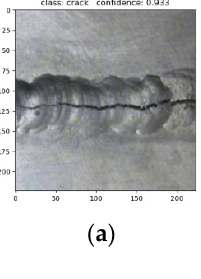
Figure 12. Prediction results of weld surface defect pictures. ( a ): The predicted defect type is crack, and the confidence is 0.933. ( b ): The predicted defect type is blowhole, and the confidence is 0.96. ( c ): The predicted defect type is incomplete fusion, and the confidence is 0.996. ( d ): The predicted defect type is normal, and the confidence is 1.0. (